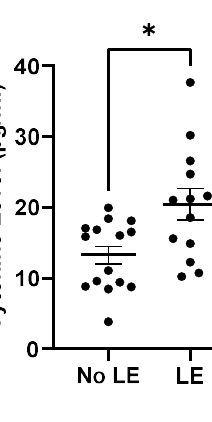
Figure 4. Plasmas IL-15, IL-3, and MIP-1 β levels at 12-months post-RT were significantly elevated in subjects who were diagnosed with clinical BCRL at 12-months post-RT compared to those who did not. * p ≤ 0.05, ** p ≤ 0.01. 3.3. Subjects Displaying Dermal Backflow One Year after RT Showed Elevated Cytokine/Chemo- kine Levels at Pre-ALND